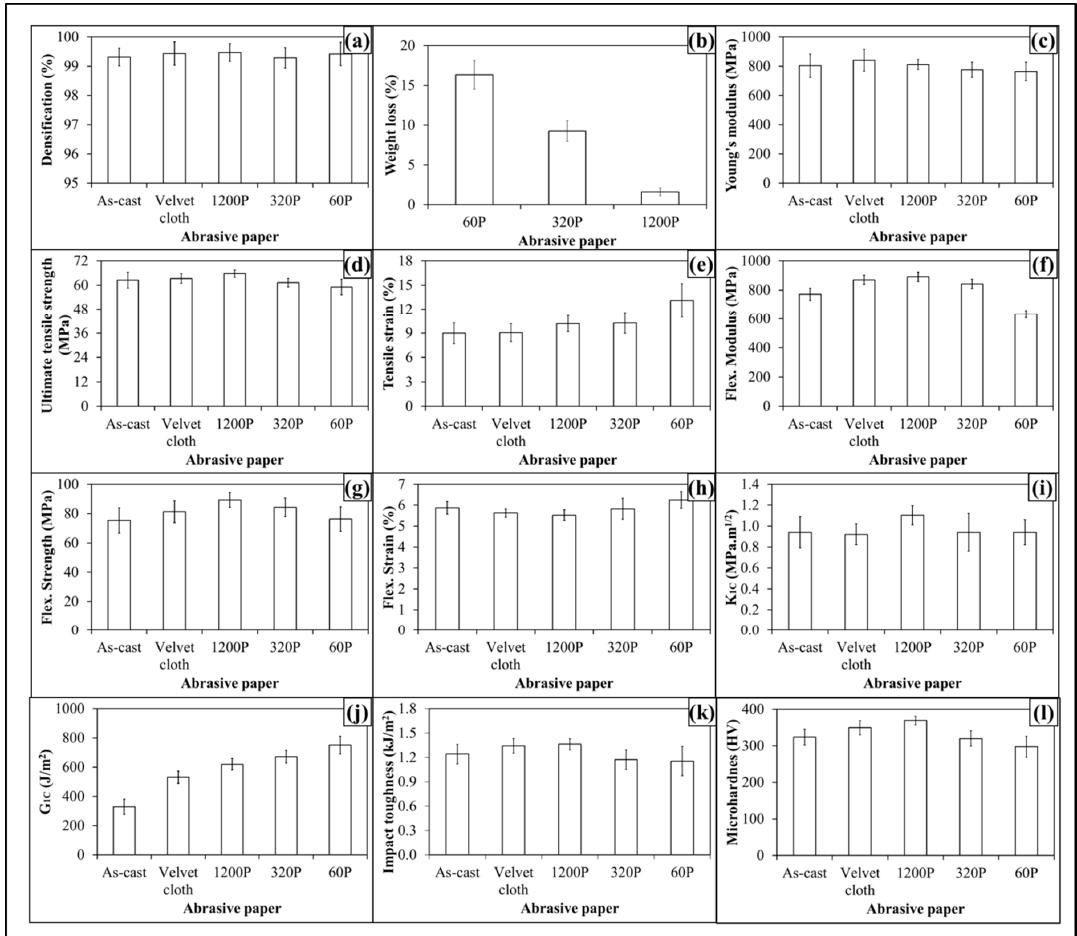
Figure 15. ( a ) Densification; ( b ) weight loss (%); ( c – l ) Mechanical properties of 0.05 wt%